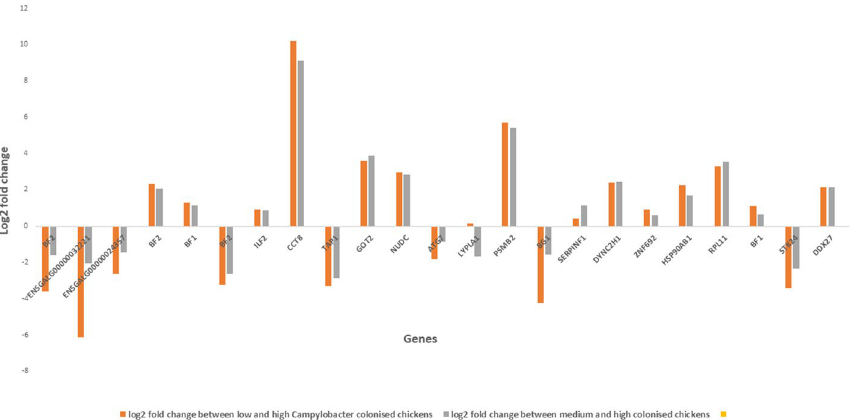
Figure 2. Differential expression analysis results. Differential expression of genes in chickens with different (low, average and high) Campylobacter colonisation levels. Each column represents relative gene expression levels in the caecal tonsils of chickens. Expression level is shown as log2 fold change in gene expression in caecal tonsils from chickens colonised at low and average levels relative to expression in chickens colonised at a high